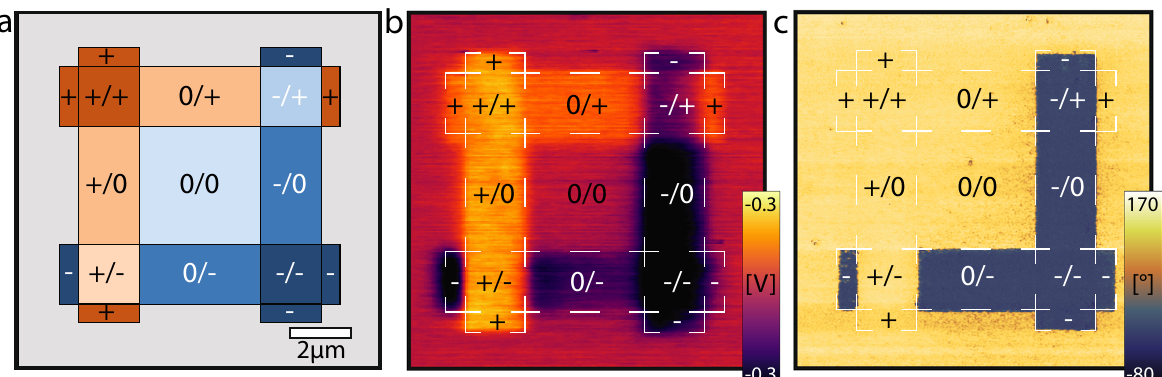
Fig. 1 Experimental protocol for mapping charge dissipation on the ferroelectric thin fi lm surface. In each sample and at each humidity setpoint, a biased atomic force microscope tip was scanned over the surface: fi rst de fi ning lateral stripe regions with positive ( + 8 V), zero, and negative bias ( − 8 V) at 0 ∘ ; then de fi ning vertical stripe regions with identical positive, zero, and negative bias at 90 ∘ . a Schema of the target writing pattern. b Typical contact potential difference (CPD) image of the resulting structure, with overlaid writing bias pattern. c Ferroelectric domain structure resulting from voltage application on the down-polarised sample (PFM phase